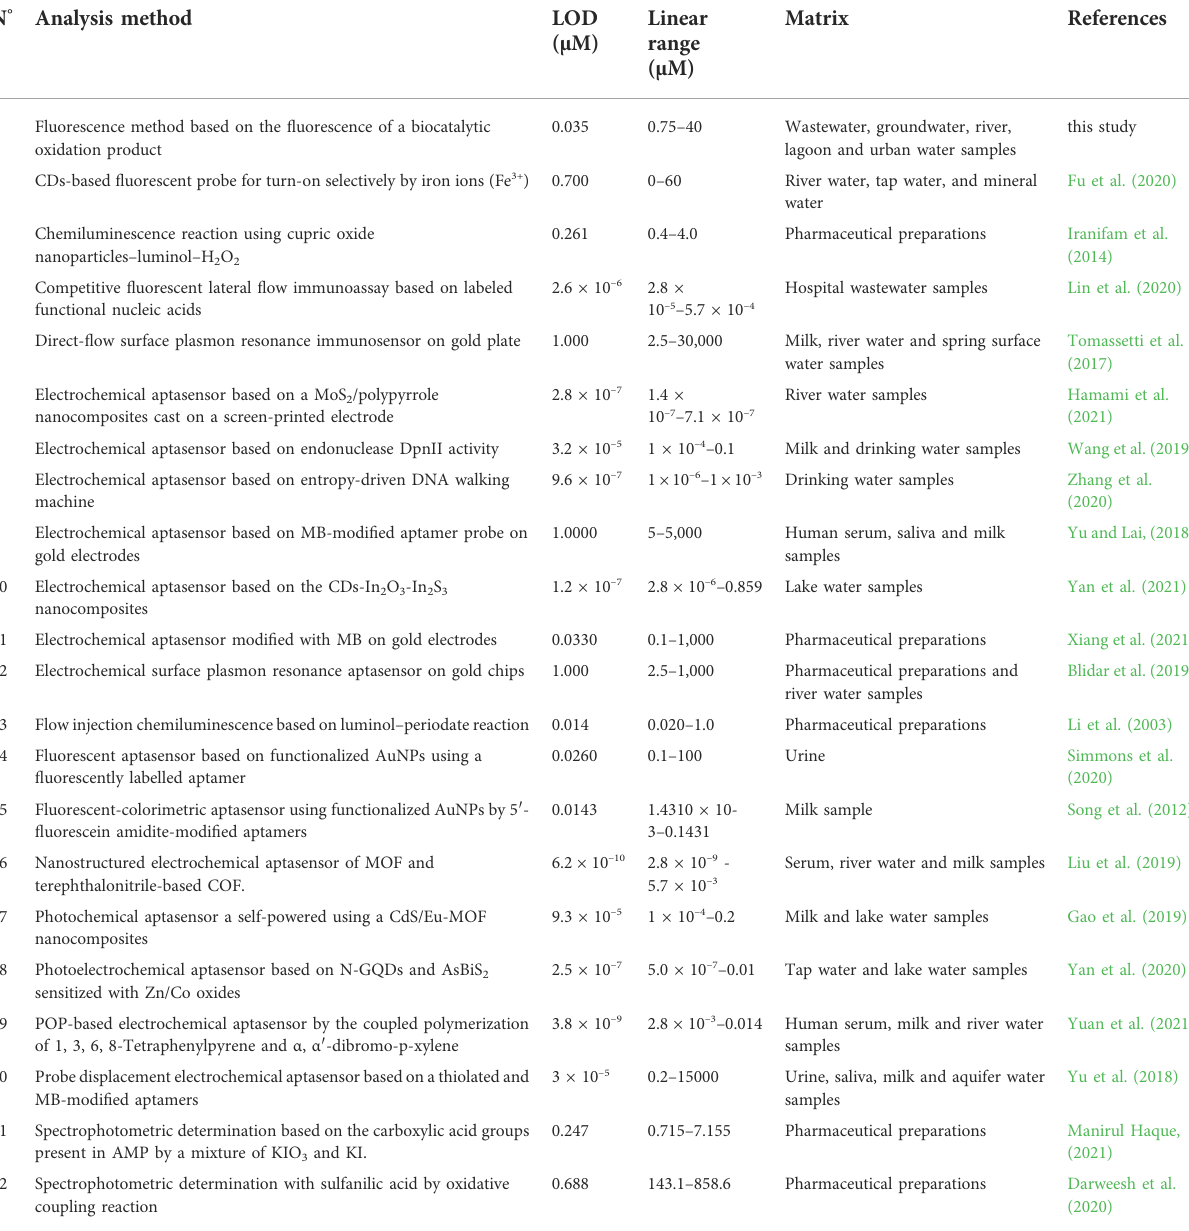
TABLE 3 Limit of detection of several methods for ampicillin